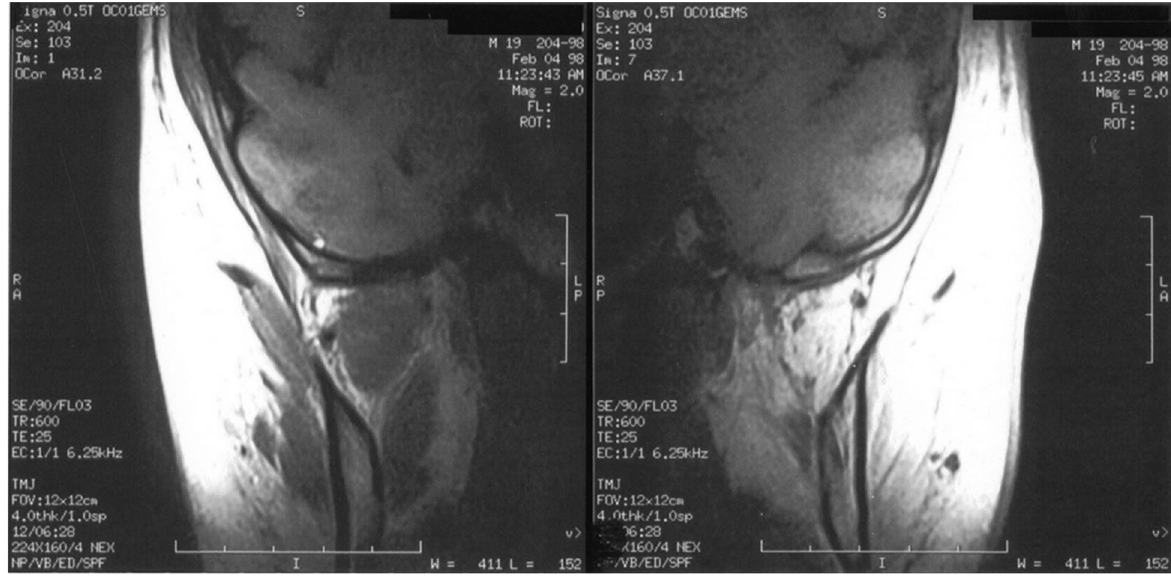
Fig. 4 MRI coronal T1-weighted scans. a Right side: the masticatory muscles appear normal. b Left side: masticatory muscles appear severely